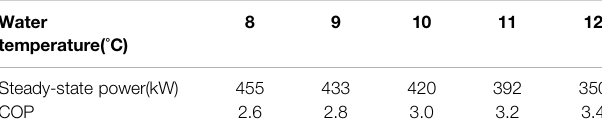
TABLE 1 | Chilled water temperature and steady-state power of